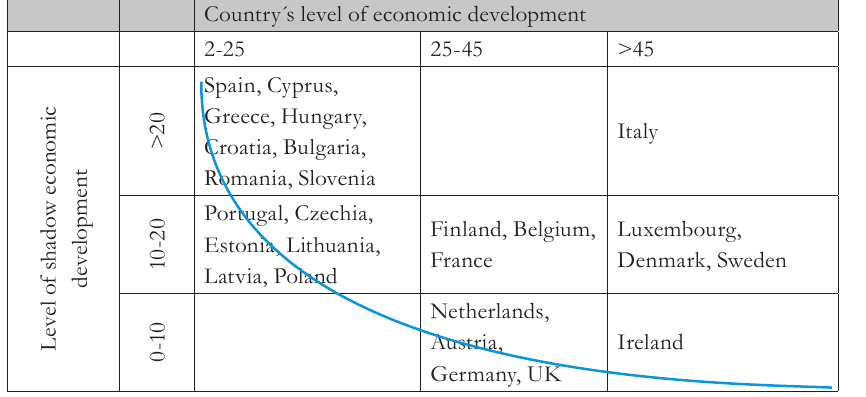
Fig. 3 – Situation of EU member states in terms of the ratio of GDP per capita (the level of national economic development) to the size of the shadow economy. Source: own